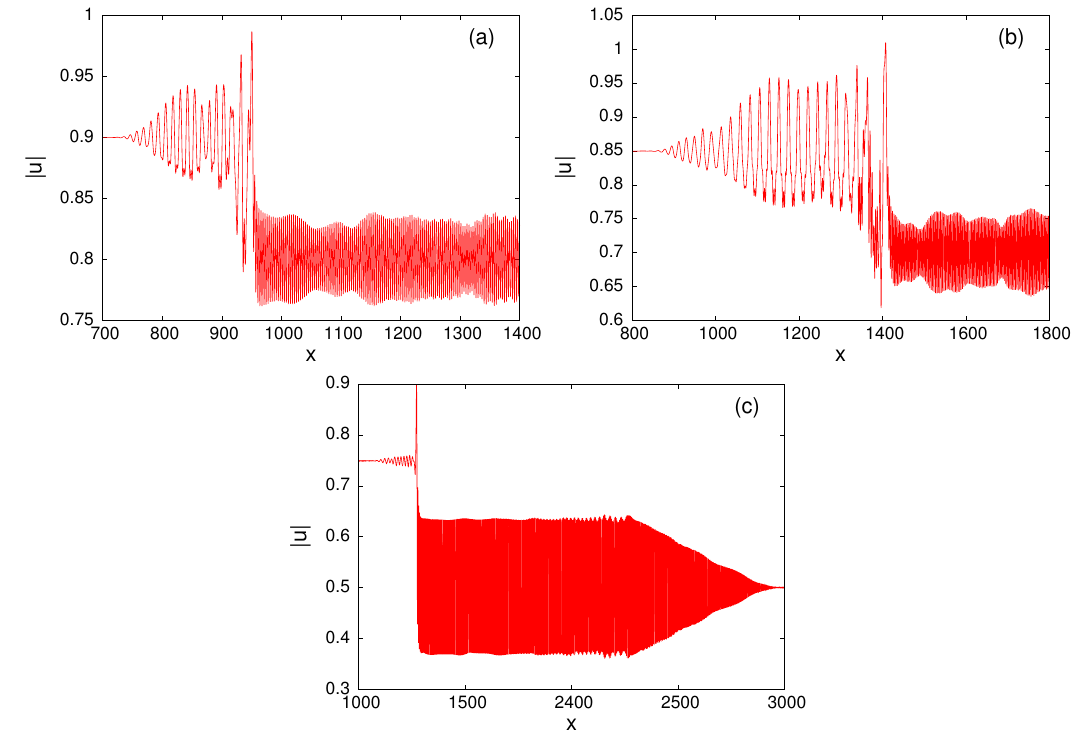
Figure 7. Numerical solution of nematic Equations (11) and (12) in the CDSW regime for the initial condition (13). ( a ) u + = 0.8 at z = 1000, ( b ) u + = 0.7 at z = 1500, ( c ) u + = 0.5 at z = 1500. Here, u − = 1.0 and q =